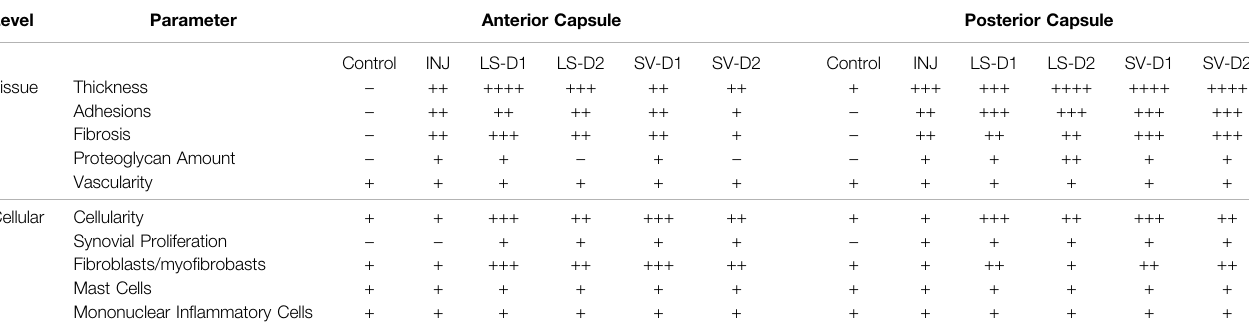
TABLE 1 | Histological semi-quantitative scoring of the anterior and posterior capsule highlighted altered tissue and cellular properties post-injury and treatment. In the anterior capsule, INJ induced tissue-level thickening, proteoglycan deposition, and development of fi brosis and adhesions; SV-D2 is the only treatment that modestly reduced proteoglycans,adhesions,and fi brosis,albeitwithincreasedtissuethickness,cellularity(predominantly fi broblasts/myo fi broblasts),andsynovialproliferation.Similarobservations were made in the posterior capsule; however, SV-D2 no longer had capsular bene fi ts in reducing tissue fi brosis, adhesions, or proteoglycans. In both anterior and posterior capsules, there was no change in vascularity or the number of mast cells and mononuclear in fl ammatory cells in any group compared to Control. Note: Histological parameters were semi-quantitatively assessed and given a symbol of either − , +, ++, +++, or ++++, where increases in the number of symbols (+vs. ++++) indicate worse diseaseseverity;detailsongradingschemeisfoundin SupplementaryTableS1 ;Control (cid:1) uninjured,age-matched;INJ (cid:1) injurynodrug;LS-D1 (cid:1) losartandosingstrategy